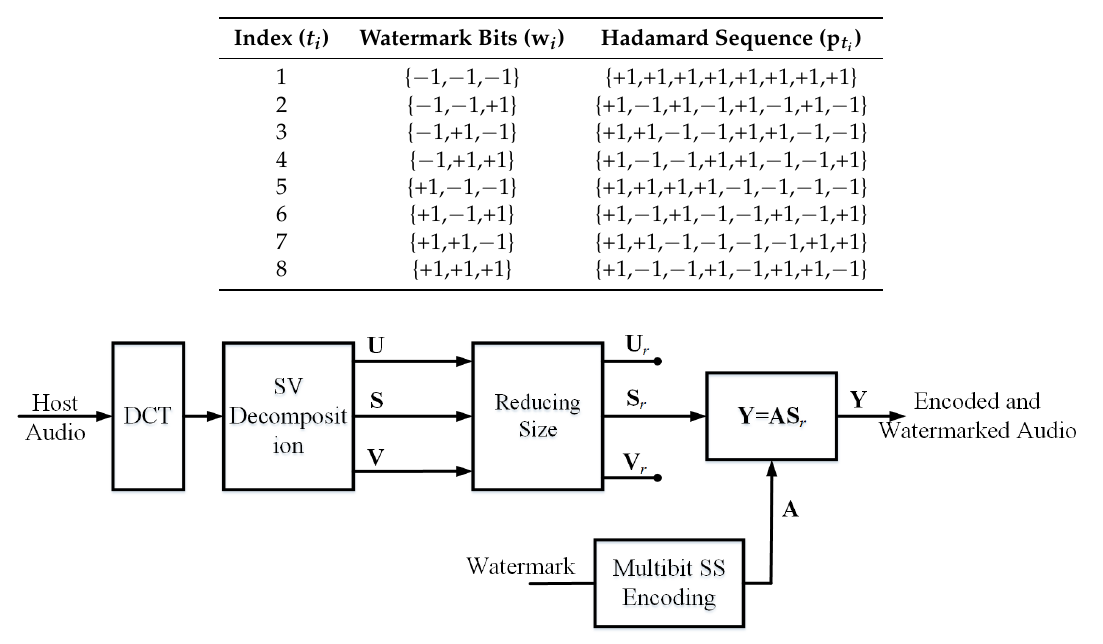
Table 2. Watermarks and Hadamard sequences’ example for N s = 3, N p = 8, and r = 8.